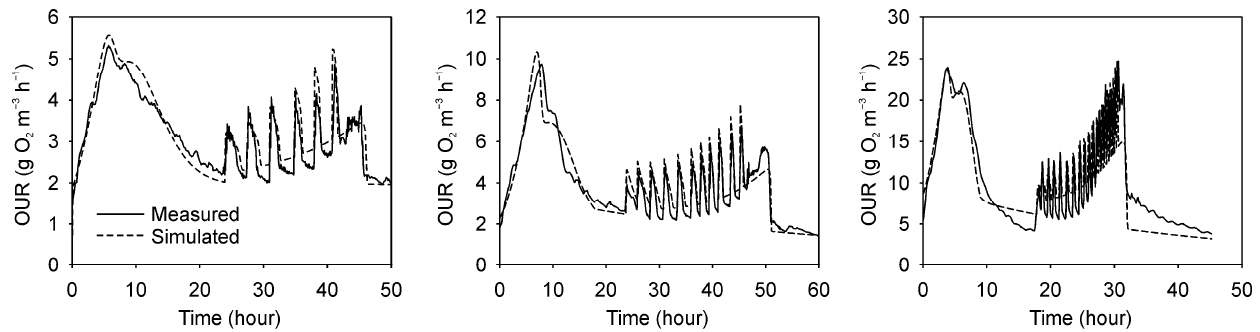
Figure 5. Model simulations of OUR measurements with the addition of sulfide.